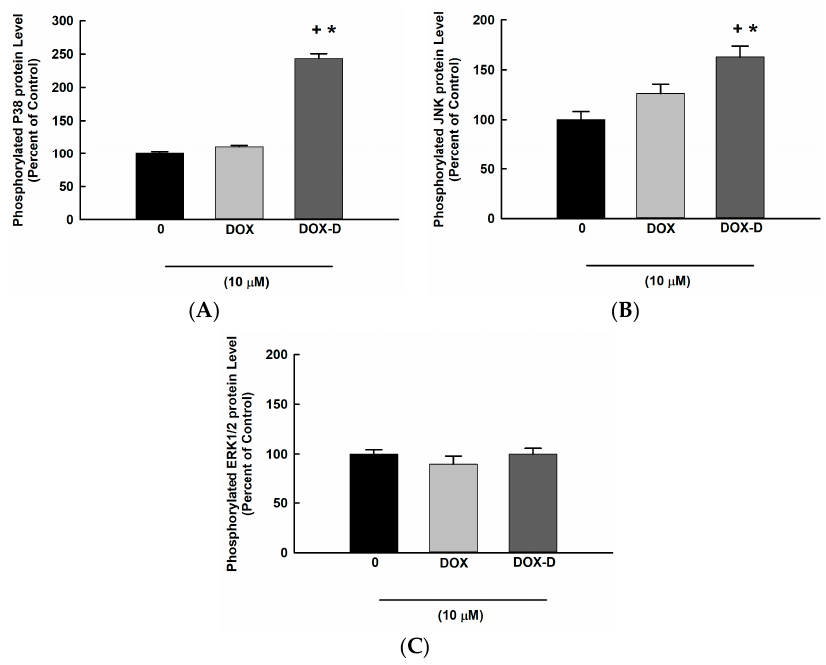
Figure 7. Effect of DOX and DOX-Vit D on MAPK signaling pathway. MG63 cells were treated for 24 h with 10 µM DOX and DOX-Vit D. Thereafter, MAPKs protein phosphorylation was determined in